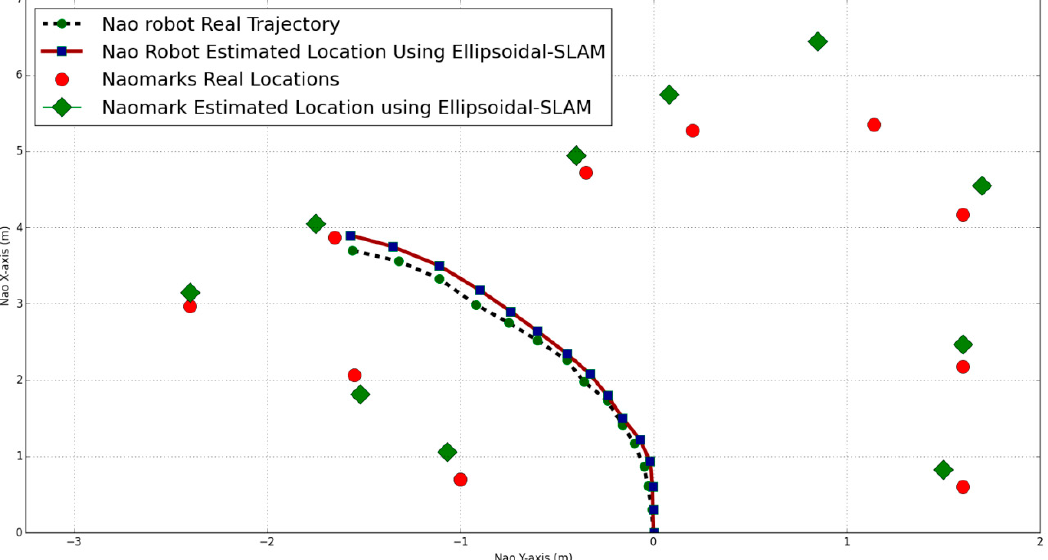
Figure 17. NAO location and NAO marker positions using ellipsoidal SLAM.